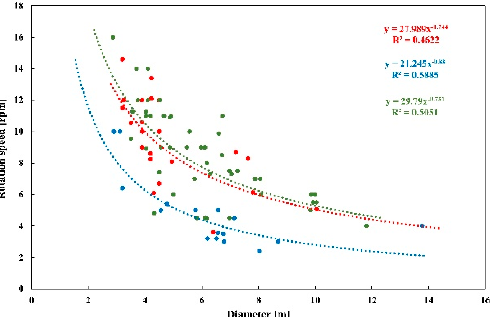
Figure 7. Correlation between the diameter and the rotation speed of the head. Red: open TBM open; blue: single shield TBM; green: double shield TBM.